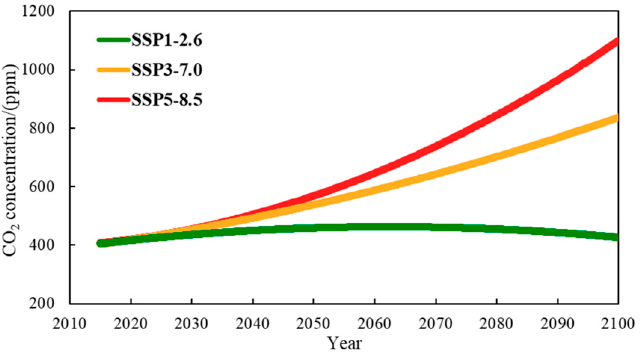
Figure A3. Regionally averaged CO 2 concentration (units: ppm) during 2015–2100 relative to 1951–2014 under SSP1-2.6, SSP3-7.0 and SSP5-8.5 scenarios.